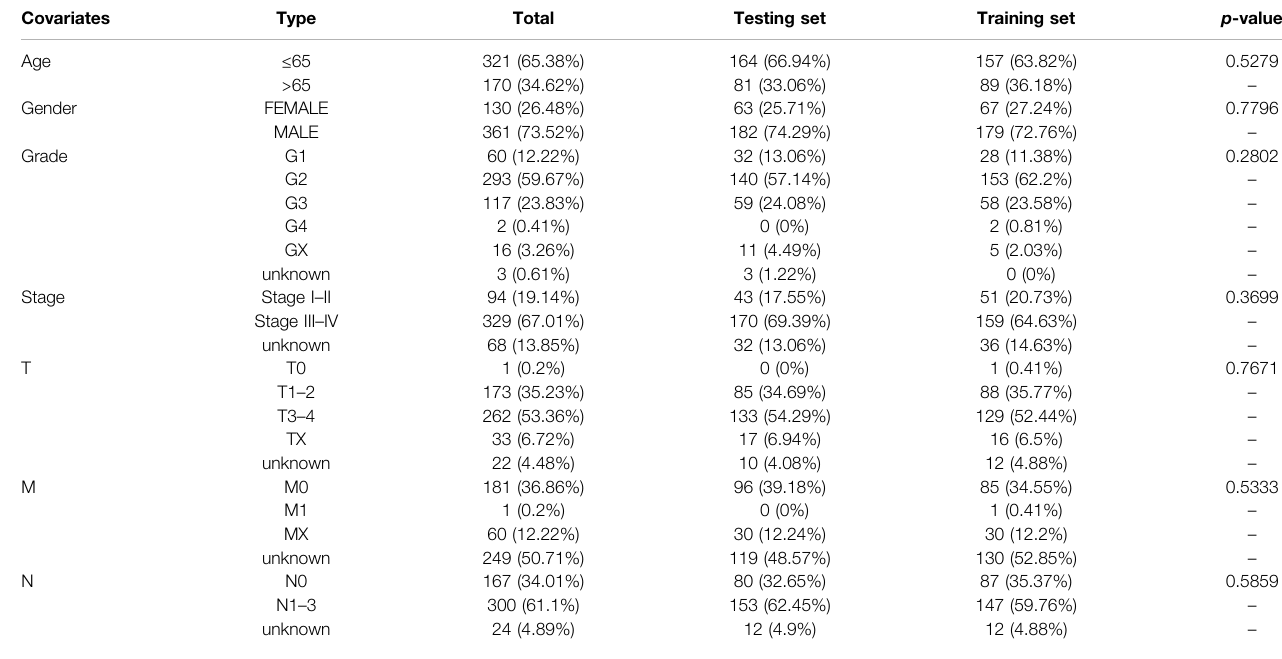
TABLE 1 | Clinicopathological information of the three HNSCC patient sets in this study. Covariates